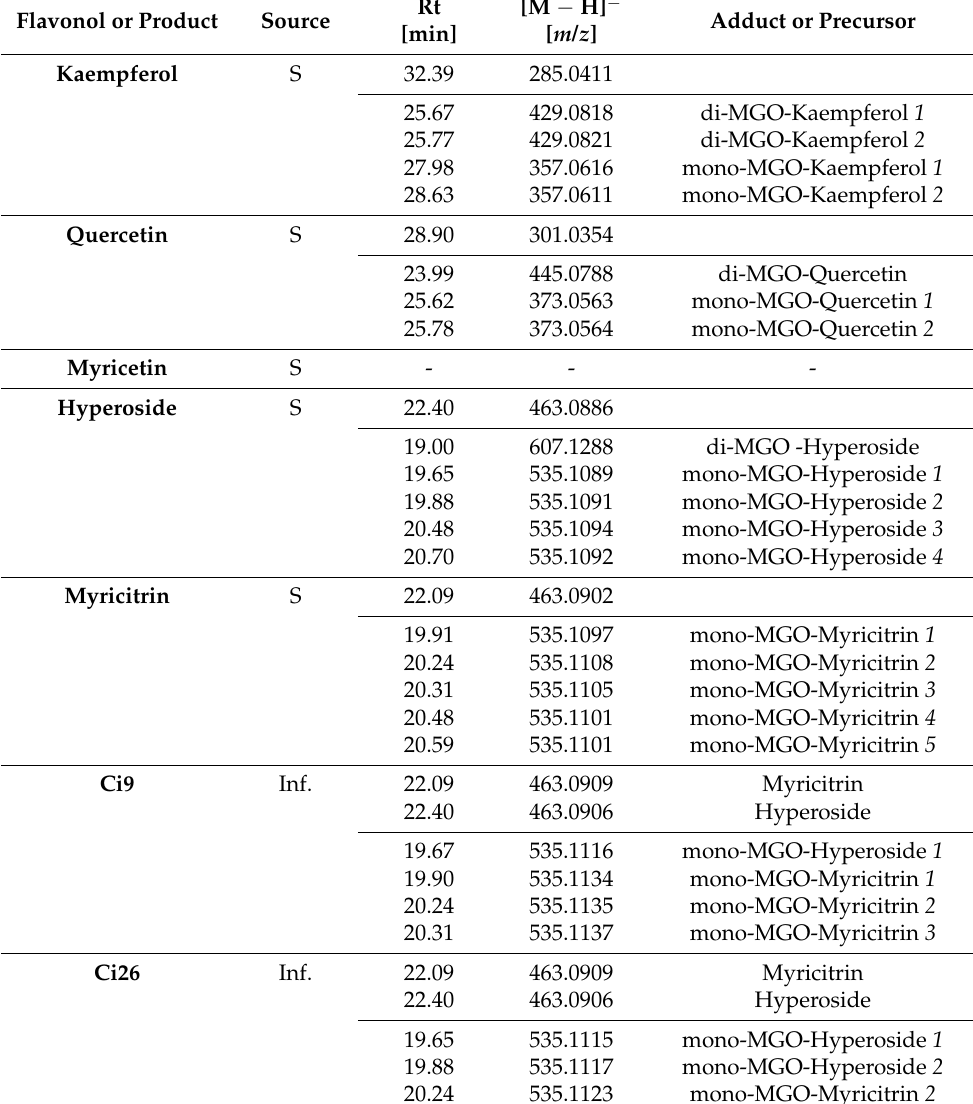
Table 5. Reaction products of methylglyoxal with flavonols (standard or present in the water infusion) formed after 1 h of incubation in phosphate buffer solution pH 7.4 at 37 ◦